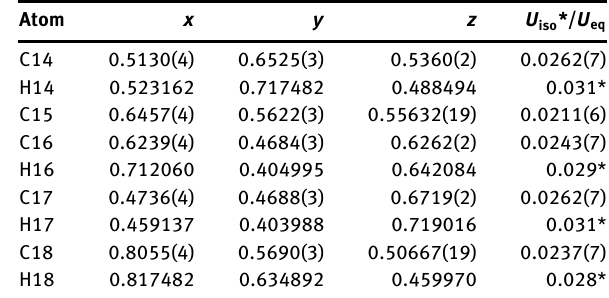
Table 2: Fractional atomic coordinates and isotropic or equivalent isotropic displacement parameters (Å 2